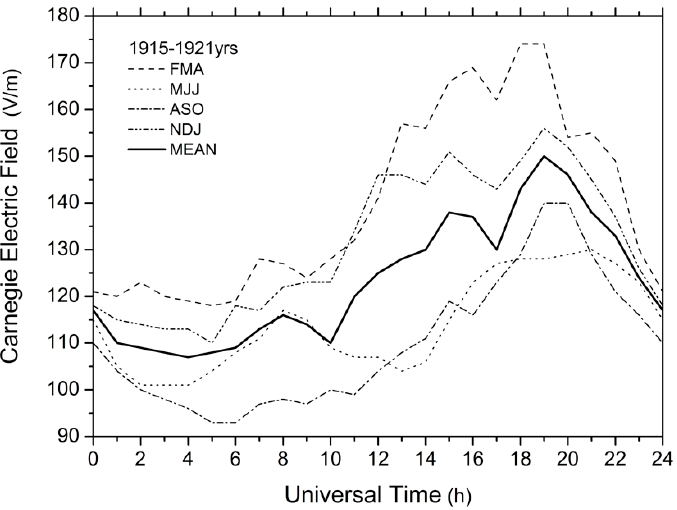
Figure 5. Averaged UT variation in the fair-weather electric field according to measurements from the Carnegie in 1915–1921. (bold curve); thin curves represent UT variations averaged separately for February–April, FMA; May–July, MJJ; August–October, ASO; and November–January, NDJ (Mauchly, 1926)